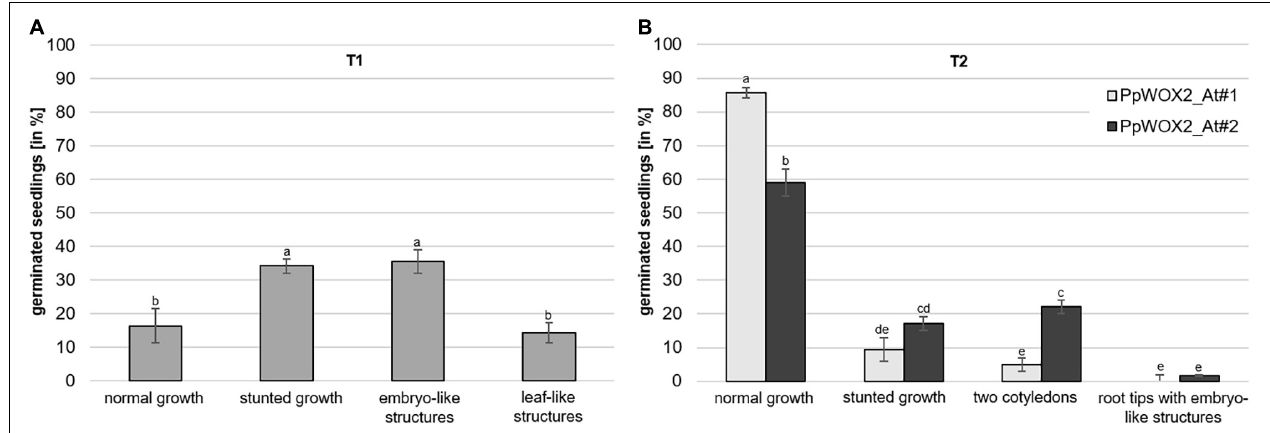
FIGURE 7 | Frequency of different phenotypes among PpWOX2 overexpressing Arabidopsis plants from the T 1 or T 2 generation. (A) T 0 seeds transformed with the 35S::PpWOX2 gene cassette were germinated and resulting T 1 plants ( N = 70–80) developed different phenotypes (normal or stunted growth, embryo-like and leaf-like structures) in various frequencies. (B) T 1 seeds transformed with the 35S::PpWOX2 gene cassette ( N = 70–80) were germinated and resulting T 2 plants from 2 independent transgenic lines ( PpWOX2 _At#1 and PpWOX2 _At#2) developed either some phenotypes similar to those of T 1 plants (normal growth and stunted growth) or new phenotypes not previously detected in the T 1 plants (only two cotyledons and plants with root tips that formed embryo-like structures). Error bars indicate standard error for means of three biological replicates and 7–8 technical replicates. Bars with different letters show significant statistical differences ( P <